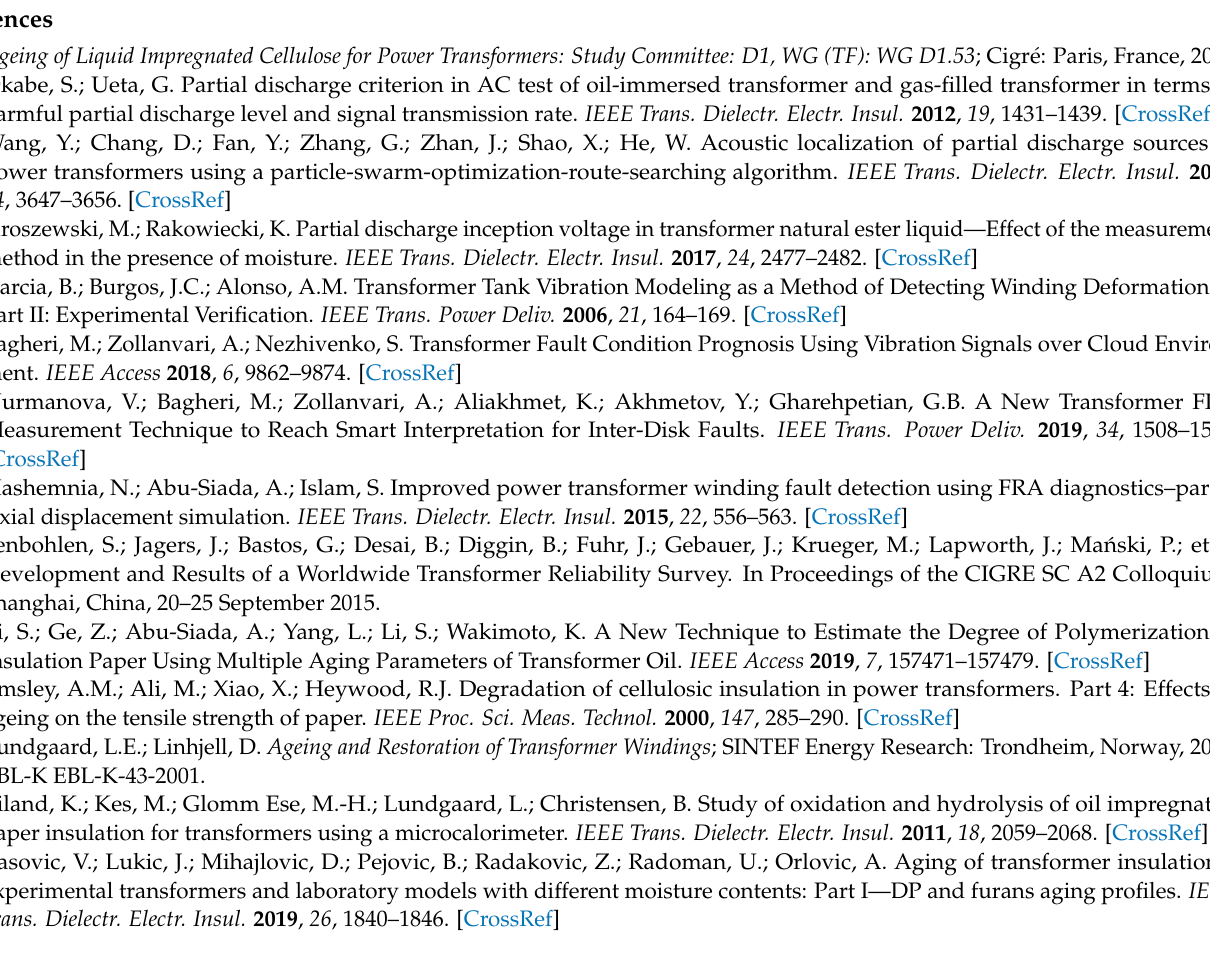
S7: Device for determining the acid value of the insulating liquid., Figure S8: Rotational viscometer for determining the dynamic viscosity η of the insulating fluid., Figure S9: Pearson correlation coefficients r for the open system with Oil A, B and C., Figure S10: Pearson correlation coefficients r for the closed system with Oil A, B and C., Figure S11: Pearson correlation coefficients r for the closed system with Ester A, B and C., Table S1: Optical appearance of the insulating materials during thermally accelerated aging for 15 weeks at 130 ◦ C. In the Supplementary Materials section, information about the measuring devices, as well as the optical change of the insulating material, is presented. Furthermore, the correlation of the aging markers for the different systems and fluids is presented in figures. Source